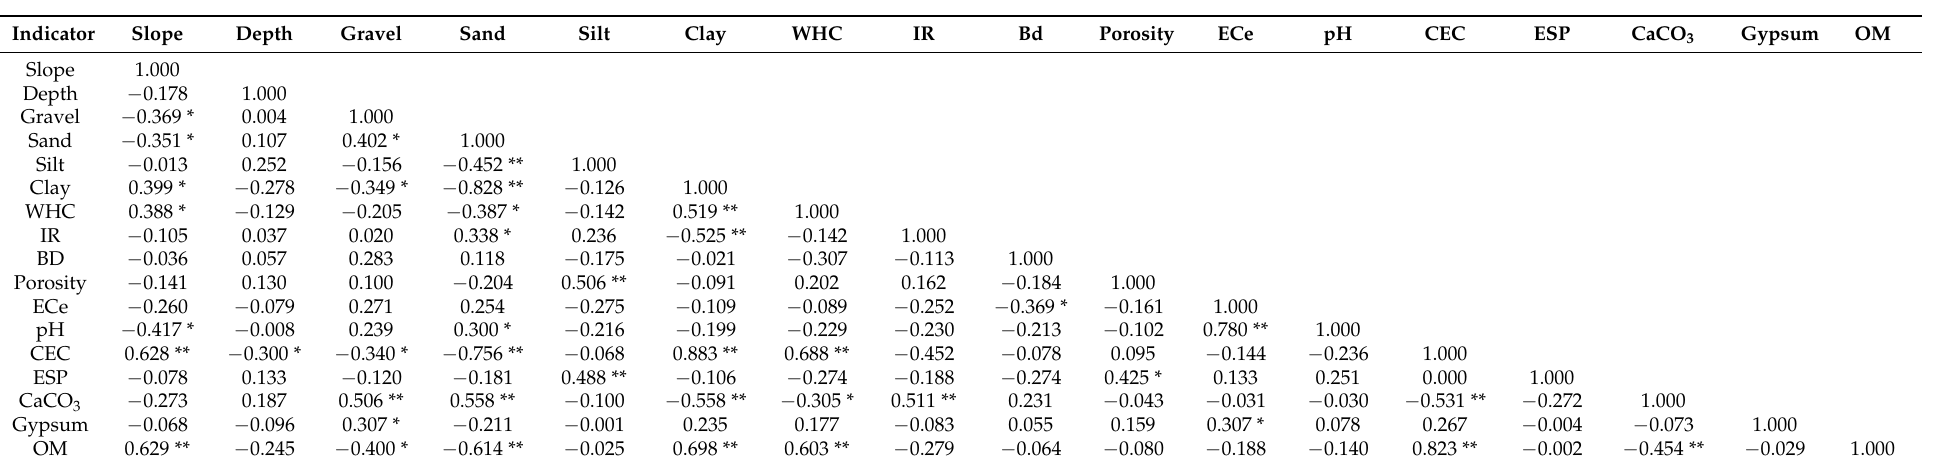
Table 3. Correlation matrix among soil indicators ( n =